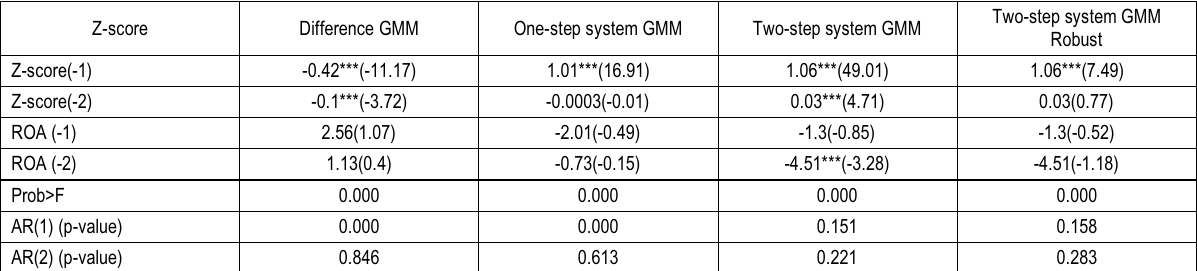
Table 5 Empirical results of the impact of profitability on insolvency